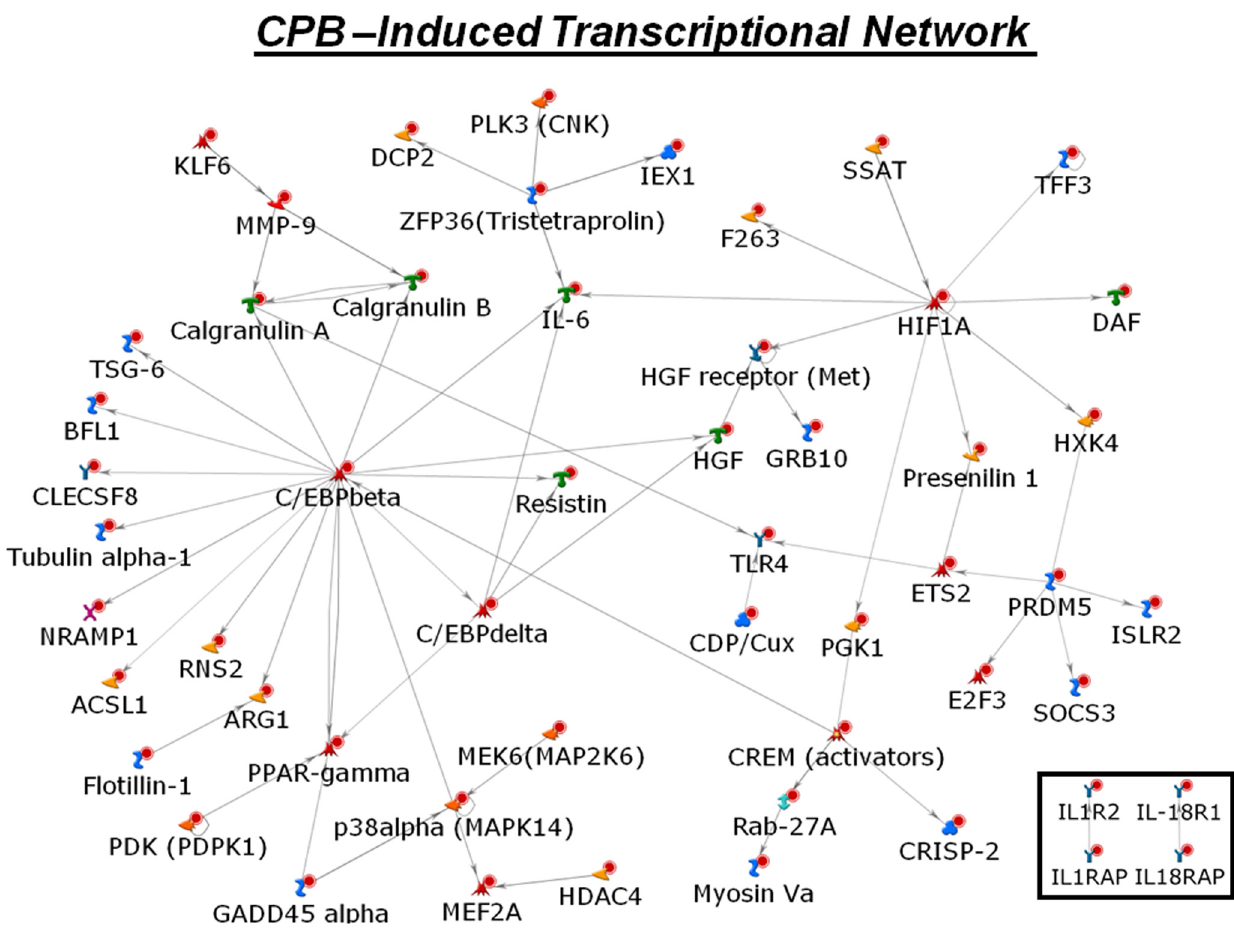
Figure 2. CS/CPB-induced gene regulatory network. A substantial fraction of CS/CPB-induced genes including both hypoxia and inflammatory related genes are directly connected and constitute an intricate transcriptional network. Network analysis reveals a critical role for hypoxia sensors HIF1alpha and c/EBPbeta in CS/CPB response. These data suggest that gene regulatory networks rather than single pathways govern the hypoxia- and immune-modulatory effects triggered by CS/CPB. Four members of IL1 receptor family were also upregulated after CS/CPB (small